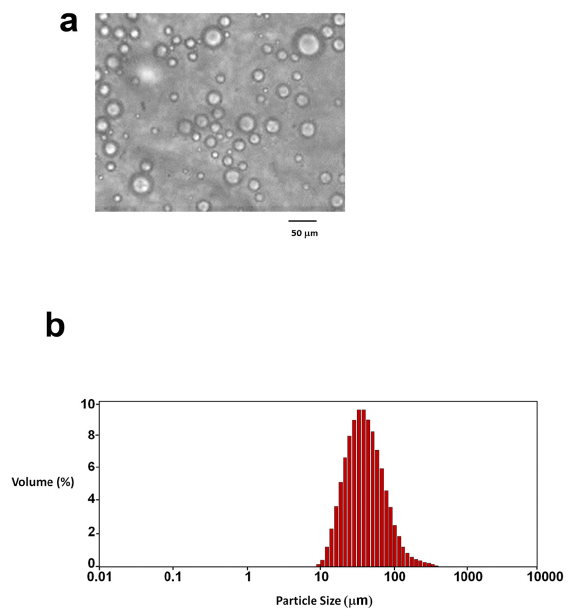
Figure 1. Image of Solid Lipid Microparticles containing DEET (a). Image obtained using a Quimis® Optical Microscope with 10x objective, Motic Images Plus 2.0® software. Polydispersion (Span) and Size of Solid Lipid Microparticles containing DEET (b) obtained using Mastersizer 2000 Malvern